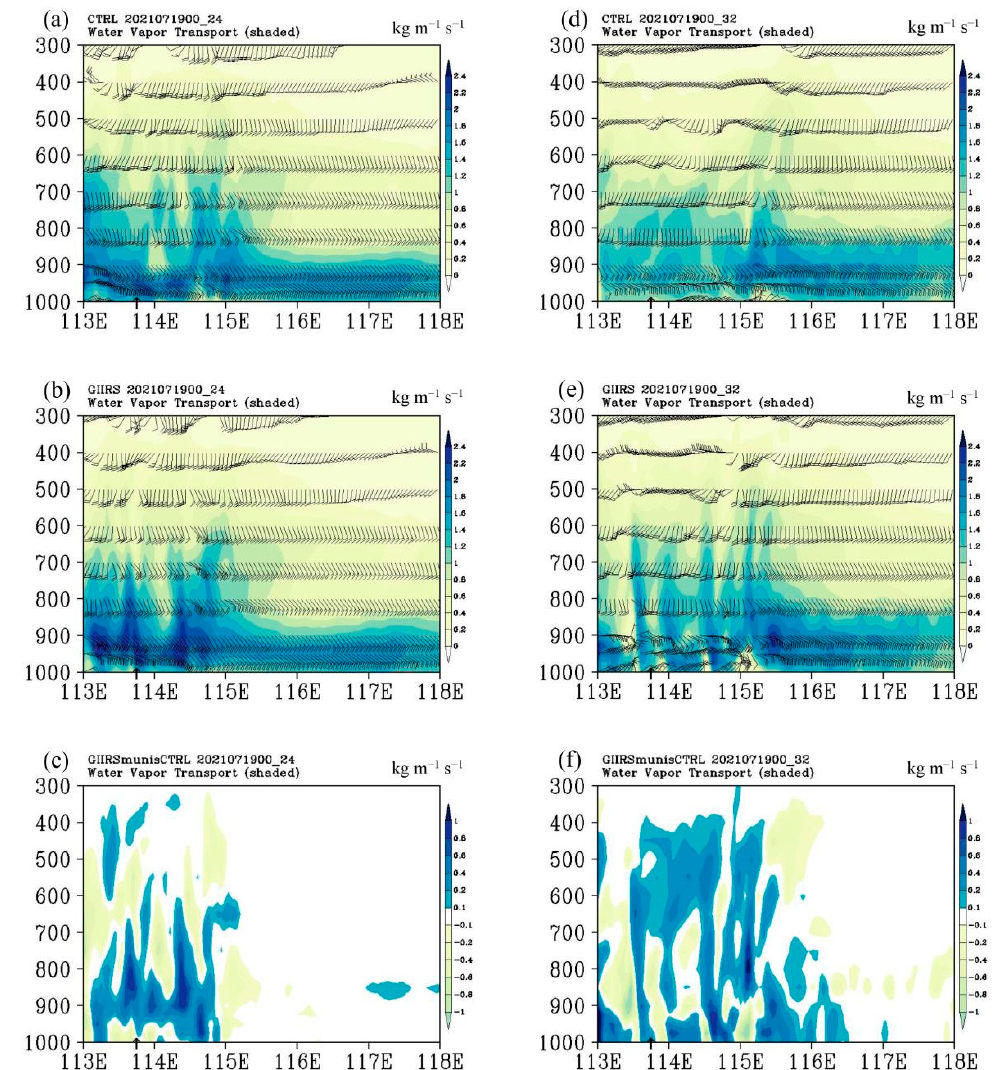
Figure 7. Vertical cross sections of water vapor flux (kg m − 1 s − 1 ) of the CTRL experiment ( a ), the GIIRS experiment ( b ), and their differences ( c ) along 34.71°N at 0000 UTC on 20 July 2021 (24 ‐ h forecast initialized from 0000 UTC on 19 July 2021). ( d – f ) are the same as ( a – c ), but for 0800 UTC on 20 July 2021 (32-h forecast initialized from 0000 UTC on 19 July 2021). The black arrow indicates Zhengzhou Station (113.66°E, 34.71°N).